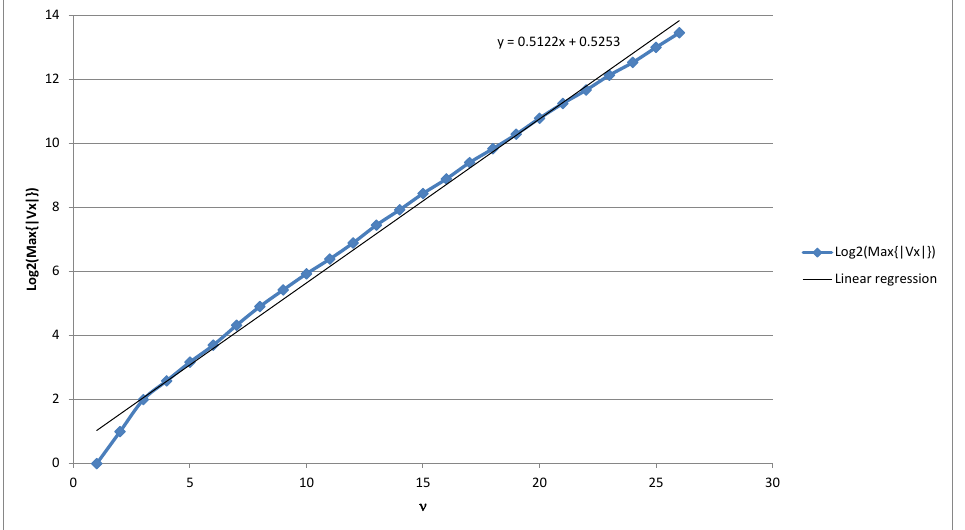
Figure 2. Linear regression for log